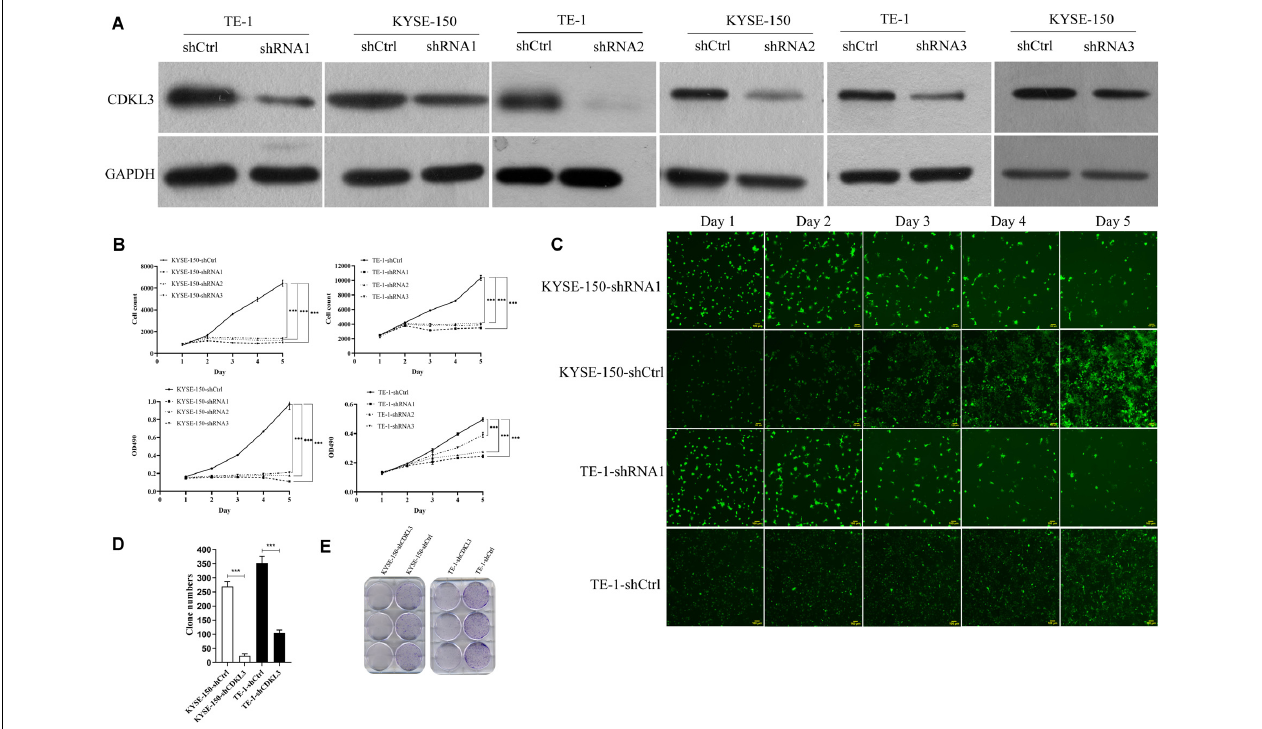
FIGURE 1 | Knockdown of CDKL3 inhibited cellular proliferation and the colony formation ability in TE-1 and KYSE-150 cells. (A) Western blot analysis showed that LV-shCDKL3 significantly downregulated protein levels of CDKL3 compared with LV-shCtrl group after 72 h infection. (B) The Celigo assay and MTT assay confirmed the inhibitory effect of CDKL3 knockdown on the proliferation rate of TE-1 and KYSE-150. (C) The typical Celigo images for the effect of CDKL3-knockdown on the proliferation of TE-1 and KYSE-150 cells. (D) CDKL3 knockdown decreased the colon numbers in TE-1-shCDKL3 and KYSE-150-shCDKL3 cells compared to TE-1-shCtrl and KYSE-150-shCtrl cells, respectively. (E) colonies of ESCC cells stained with crystal violet. Data were represented as the mean ± SD of three separate experiments. *** P < 0.001.